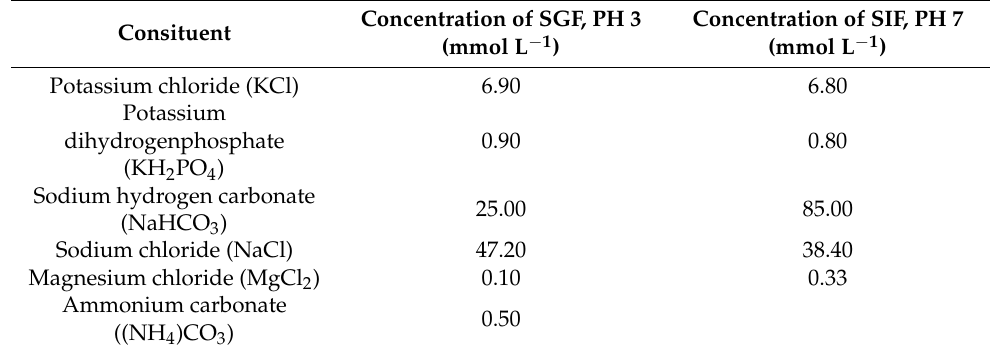
Table 5. Composition of simulated gastric and intestinal fluids (SGF and SIF,